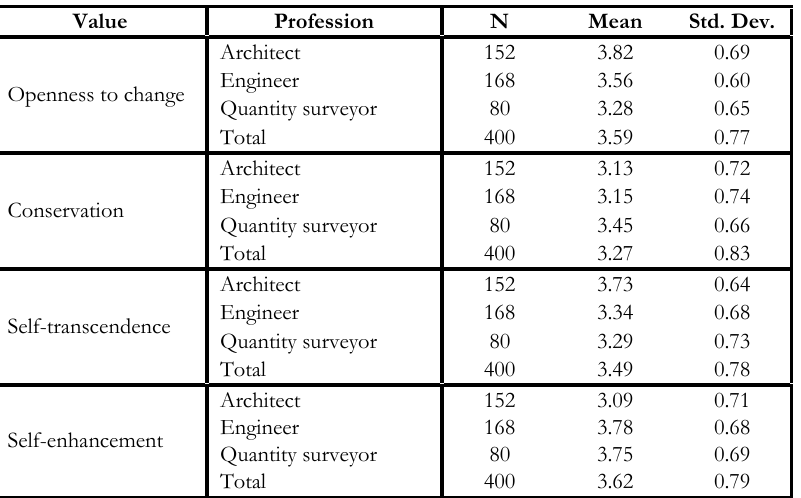
Table 5 specifies that the priority of the 4 higher-order values for architects included: